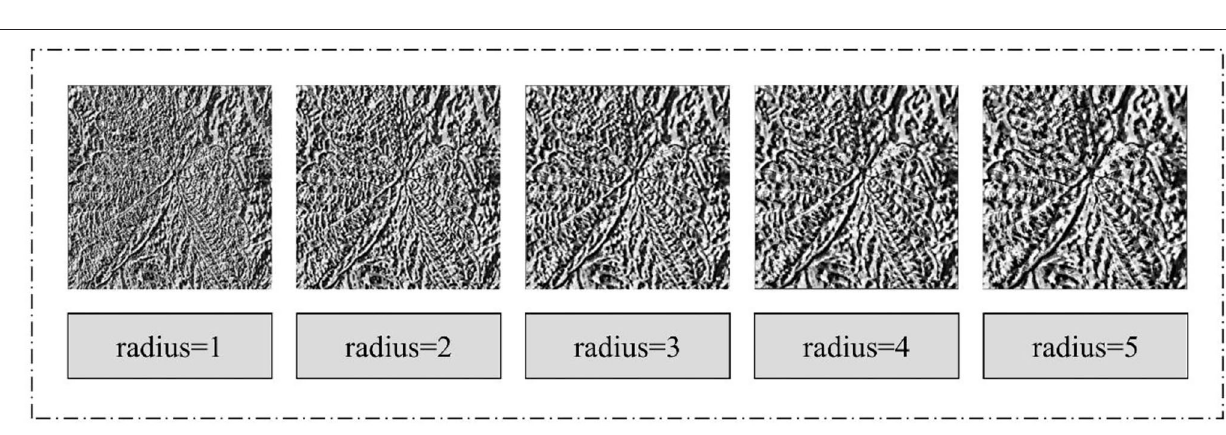
FIGURE 8 | Texture feature map extracted from the same image after selecting different domain